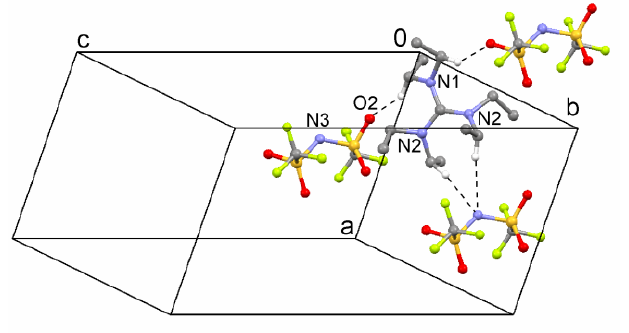
Figure 5. Short contacts in the crystal structure of hexaethylguanidinium bistriflimide ( 5 ). Hydrogen atoms have been omitted for clarity, except for those engaged in